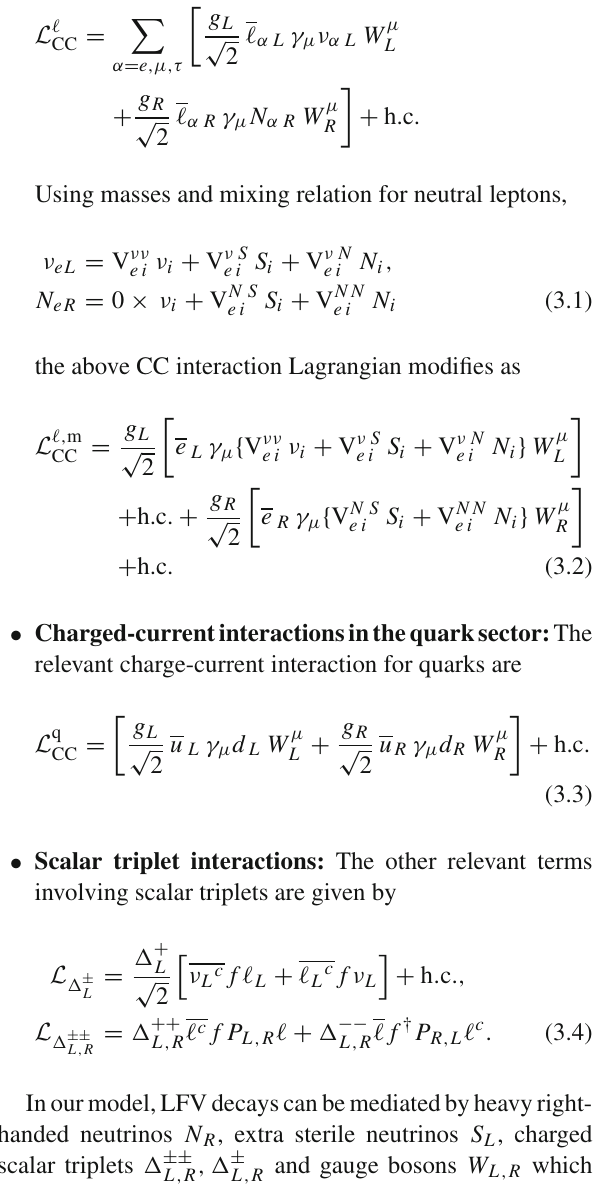
Table 3 Branching ratios for different LFV processes and their present experimental bound and future sensitivity values taken from refs [107– 113] LFVdecays(with Present bound Near future sensitiv- branching ratios) ity at ongoing search